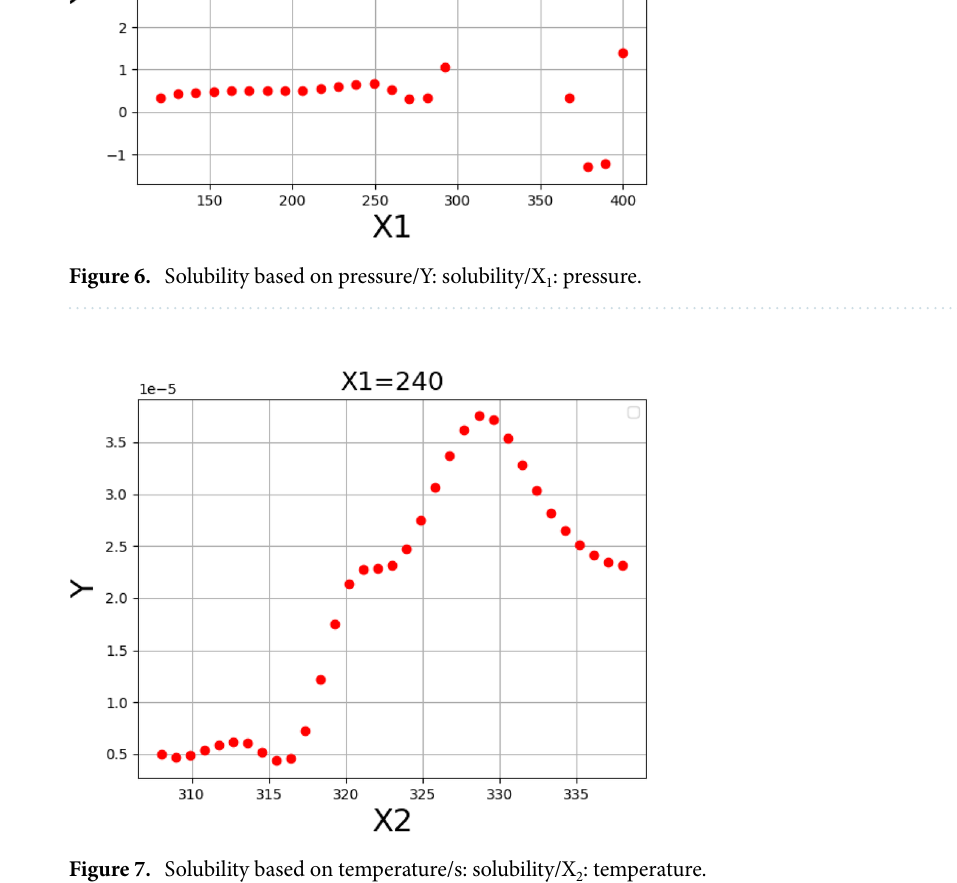
Figure 7. Solubility based on temperature/s: solubility/X 2 :